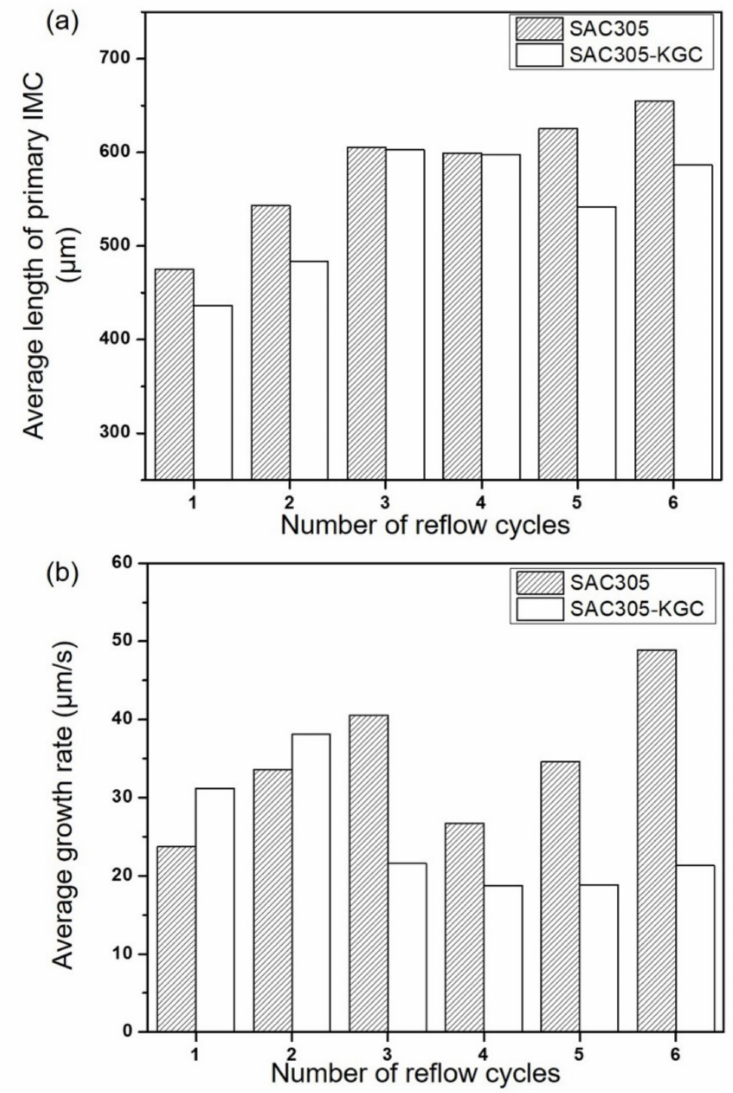
Figure 11. ( a ) Average length of the primary IMC in SAC305 and SAC305-KGC, and ( b ) Average growth rate of primary IMC in SAC305 and